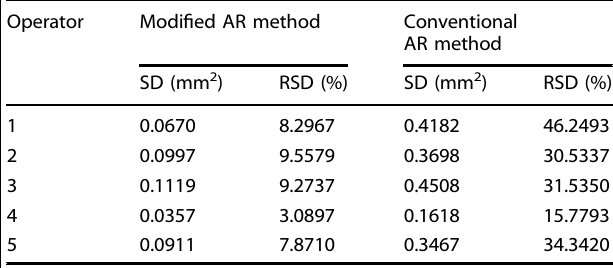
Each operator performed AR surgery in P1 neonatal mice using conventional ( n = 5) and modi fi ed ( n = 5) AR method, respectively. AR apical resection, SD standard deviation, RSD relative standard